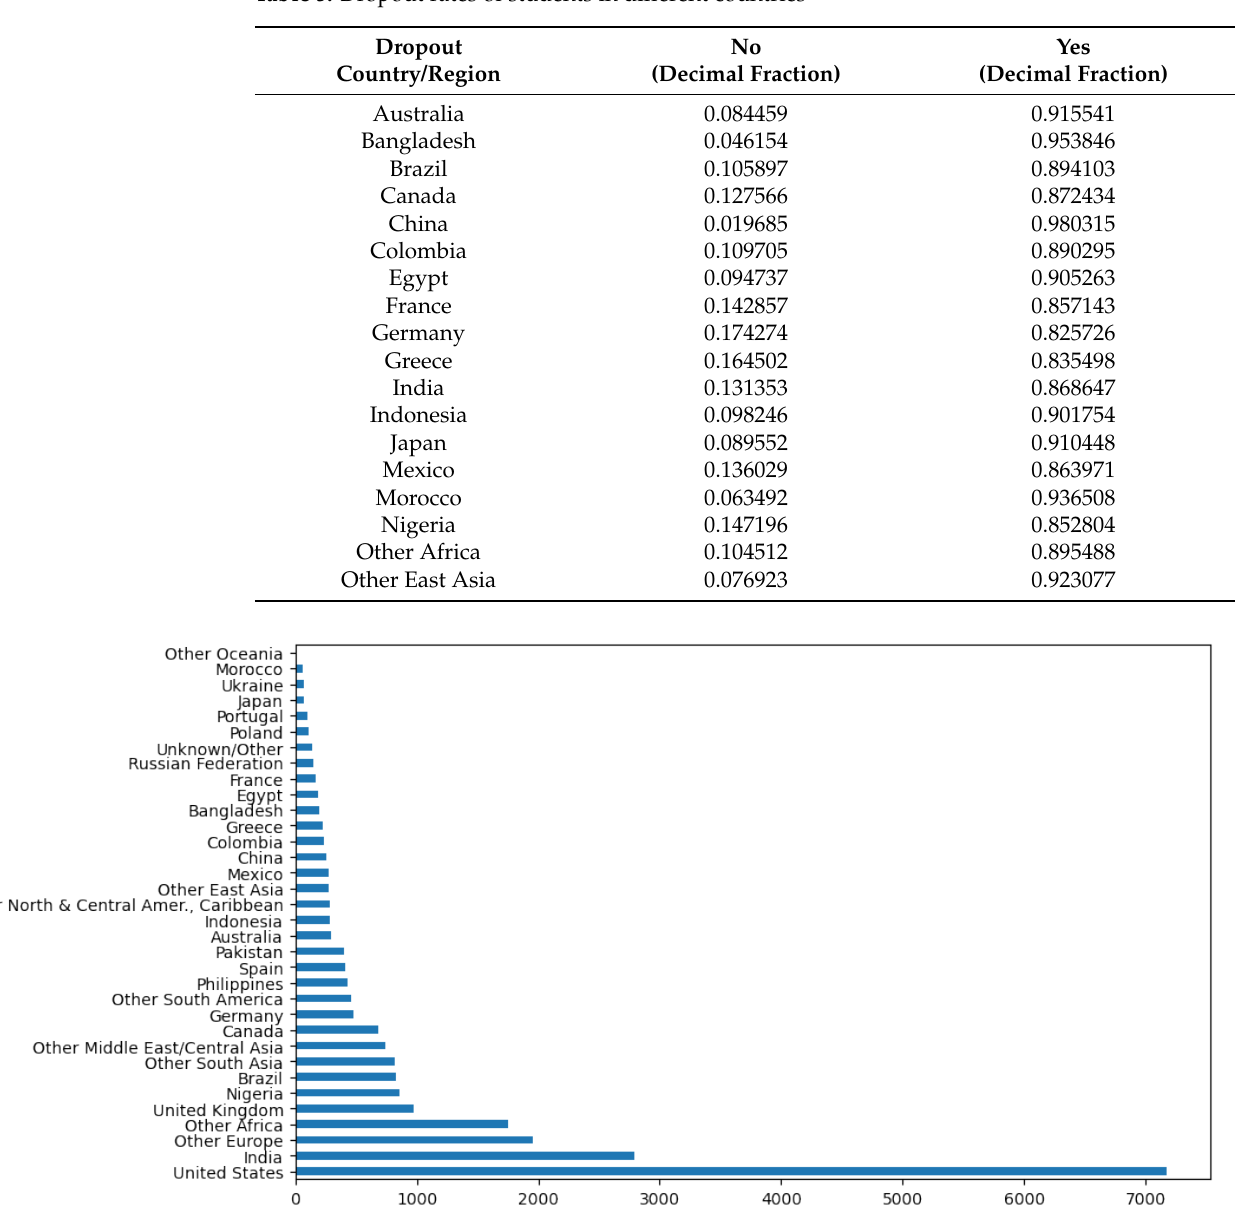
Figure 6. Comparison of the number of total students in different